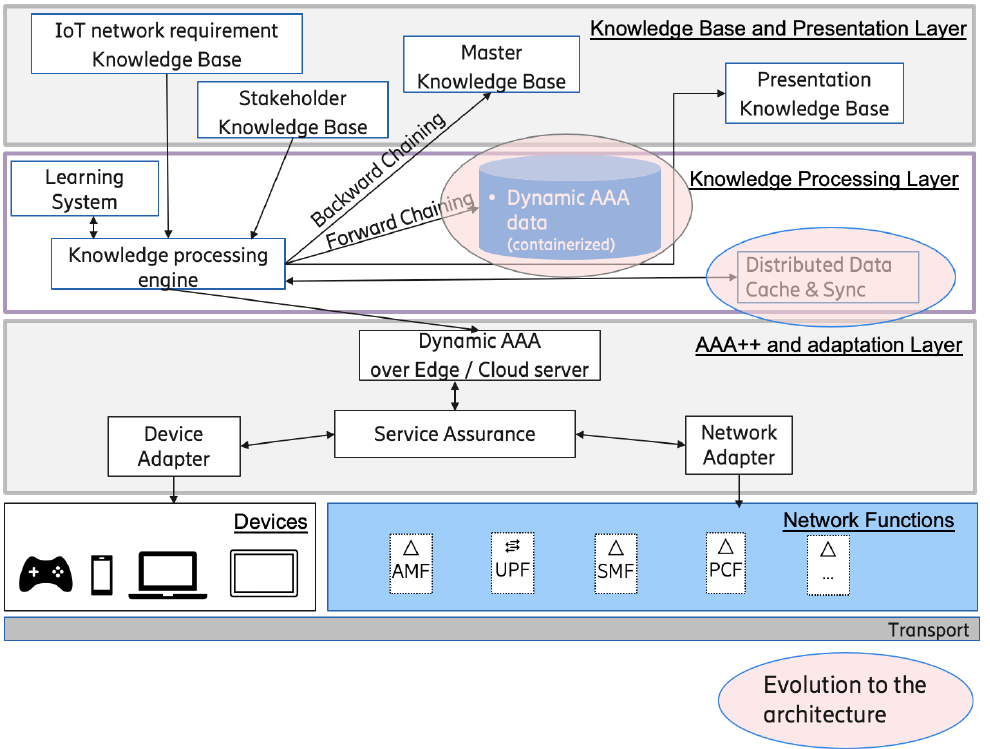
Figure 7. Smart AAA agent updated